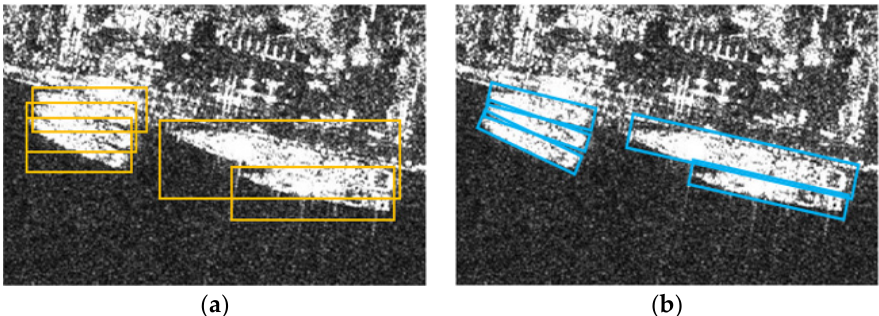
Figure 9. Comparison of RBox and BBox. ( a ) illustrates BBoxes representing targets; ( b ) illustrates RBoxes representing